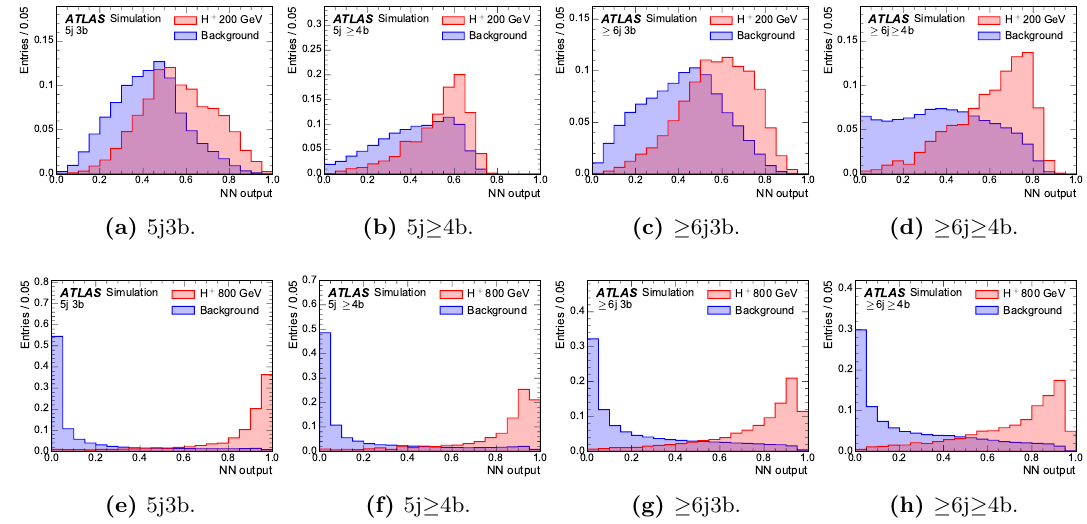
Figure 4 . Expected distributions of the NN output for H + masses of 200 GeV (top) and 800 GeV (bottom) for SM backgrounds and H + signal in the four analysis regions. All distributions are normalised to